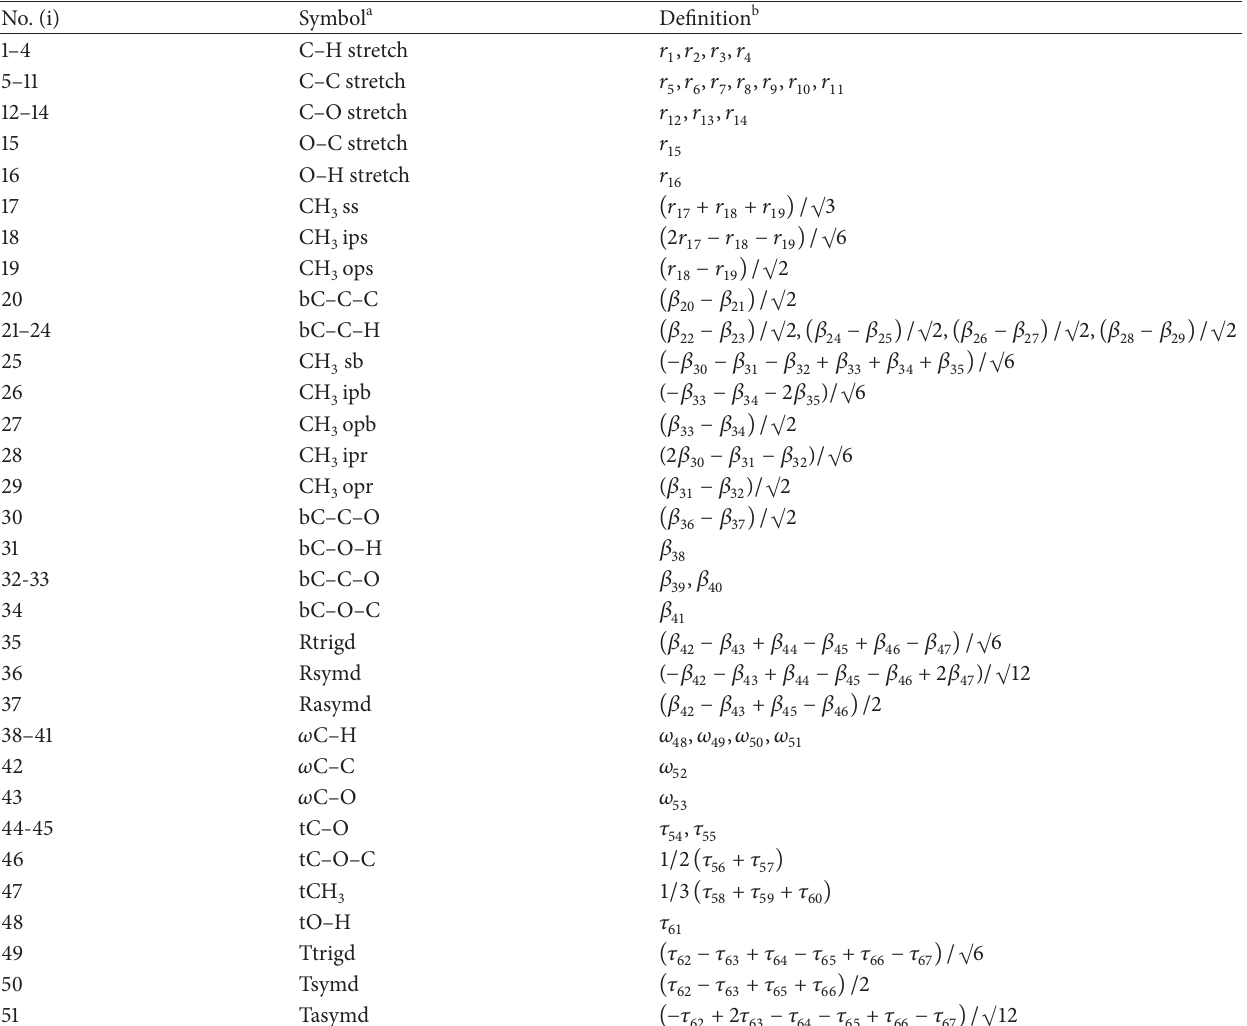
Table 4: Definition of natural internal coordinates of O-Anisic acid